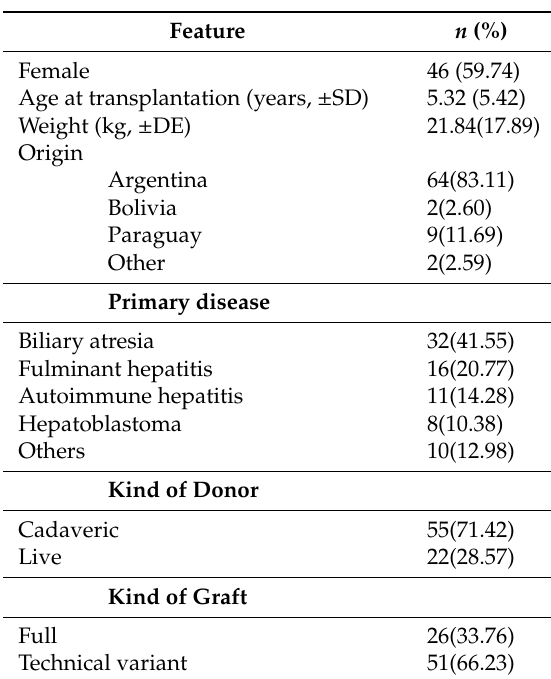
Table 1. Characteristics of the studied population ( n = 77).